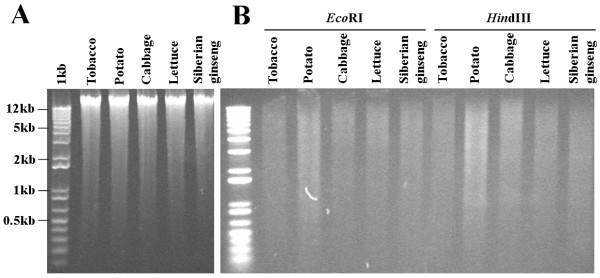
Agarose gel electrophoresis of undigested and digested genomic DNA. (A) Genomic DNA from five different plants with 5 μg of genomic DNA loaded from each sample. (B) Genomic DNA digested with the restriction enzymes EcoRI and HindIII. 1 kb, DNA molecular weight ladder.